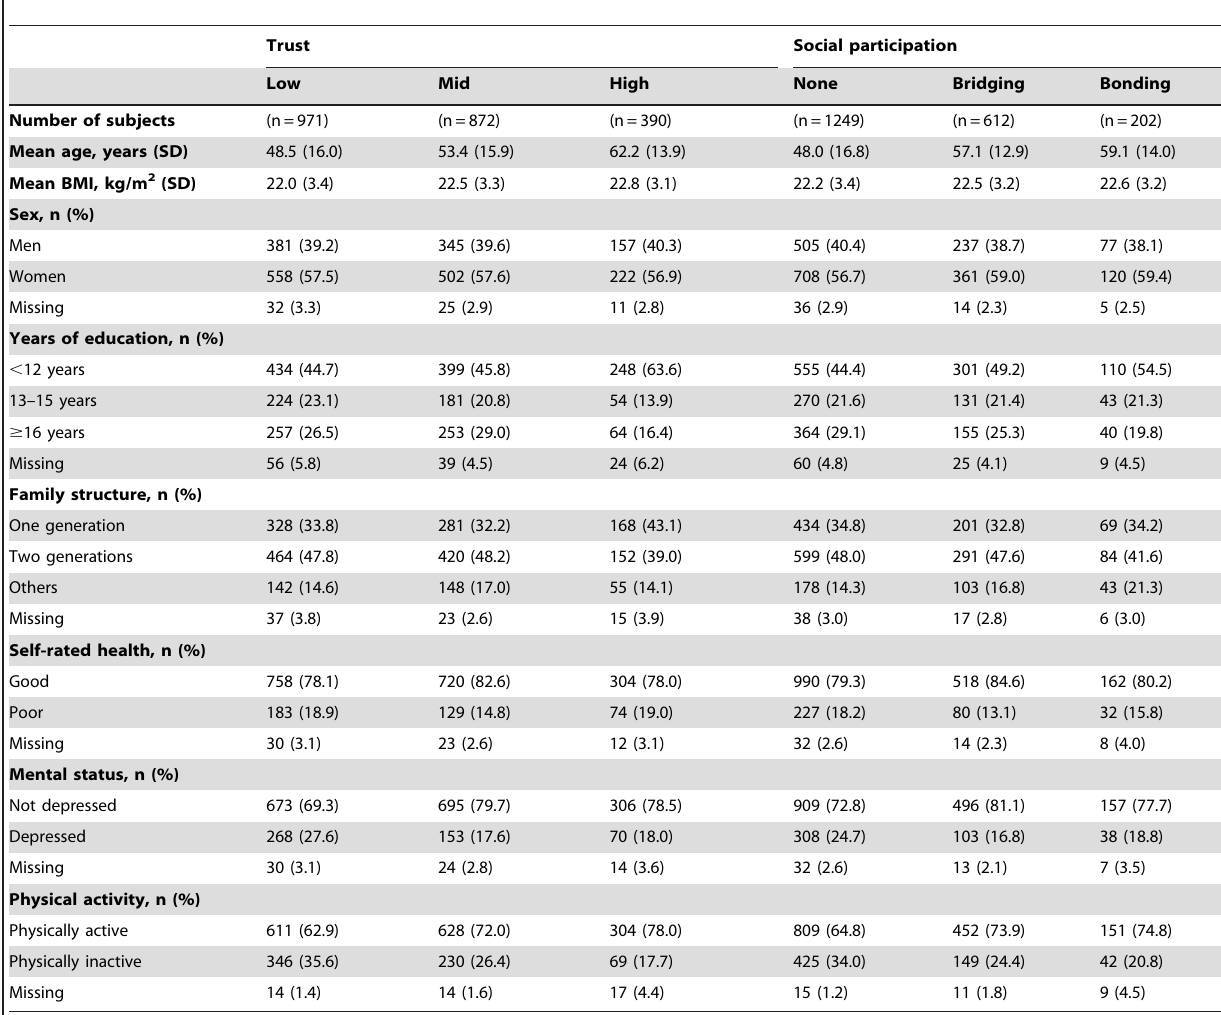
Table 3. Characteristics of study subjects according to social capital status in Okayama, Japan